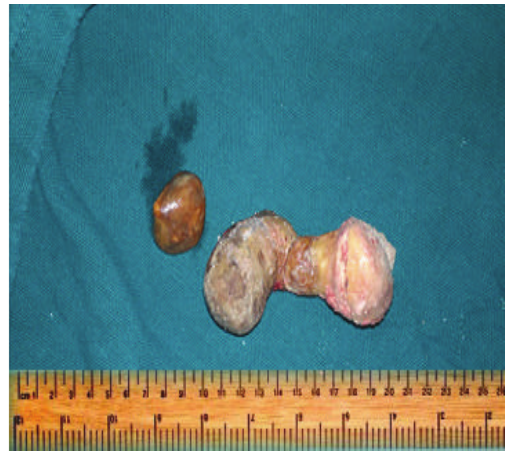
Figure 5: Picture showing two calculi one huge dumbbell shaped calculus and a smaller globular